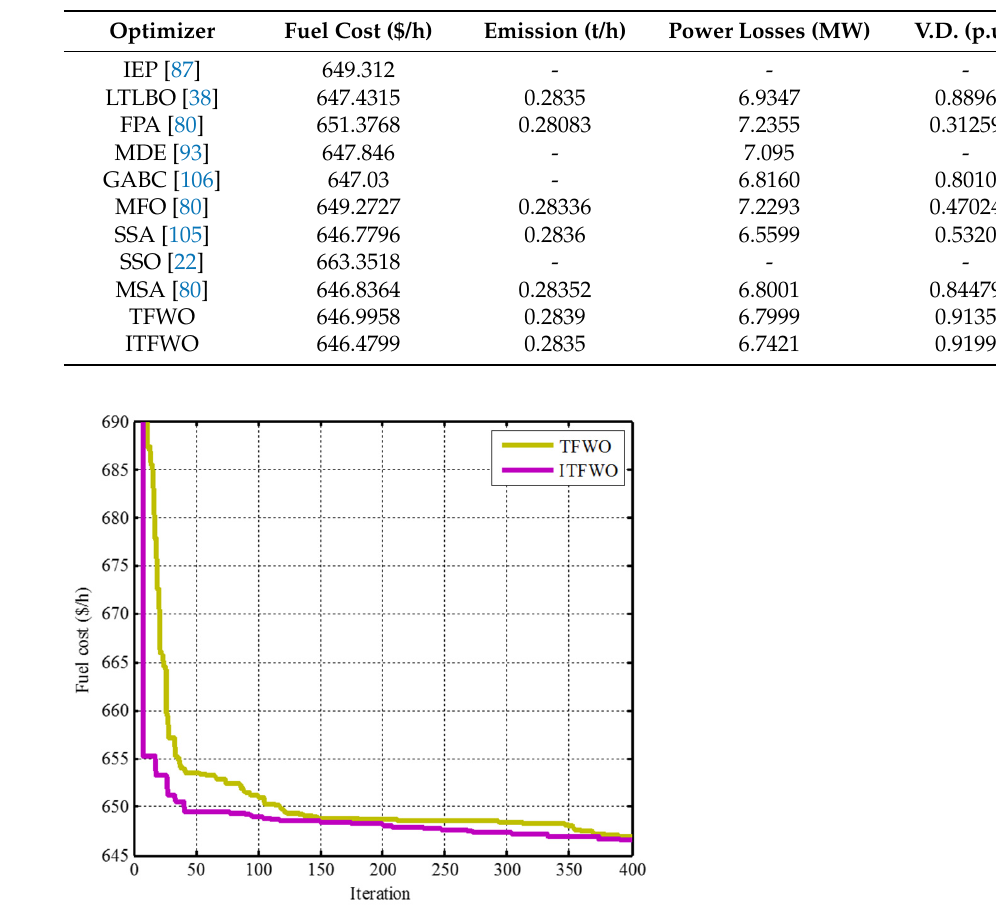
Figure 6. Optimization process for Type